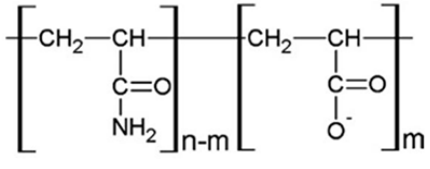
Figure 8—Repeating monomer units of HPAM.